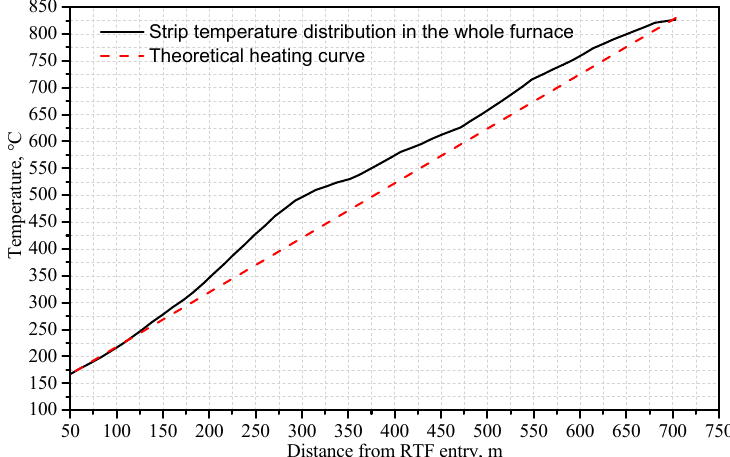
Figure 5. Strip temperature distribution in the whole furnace for sample 16.